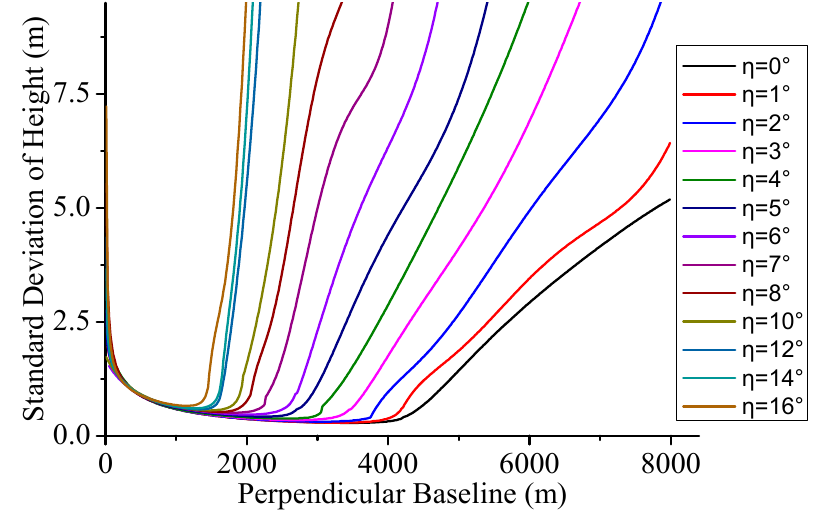
Figure 5. Standard deviation of height versus the perpendicular baseline for different terrain slopes. Table 1. Optimal perpendicular baselines for different terrain slopes.